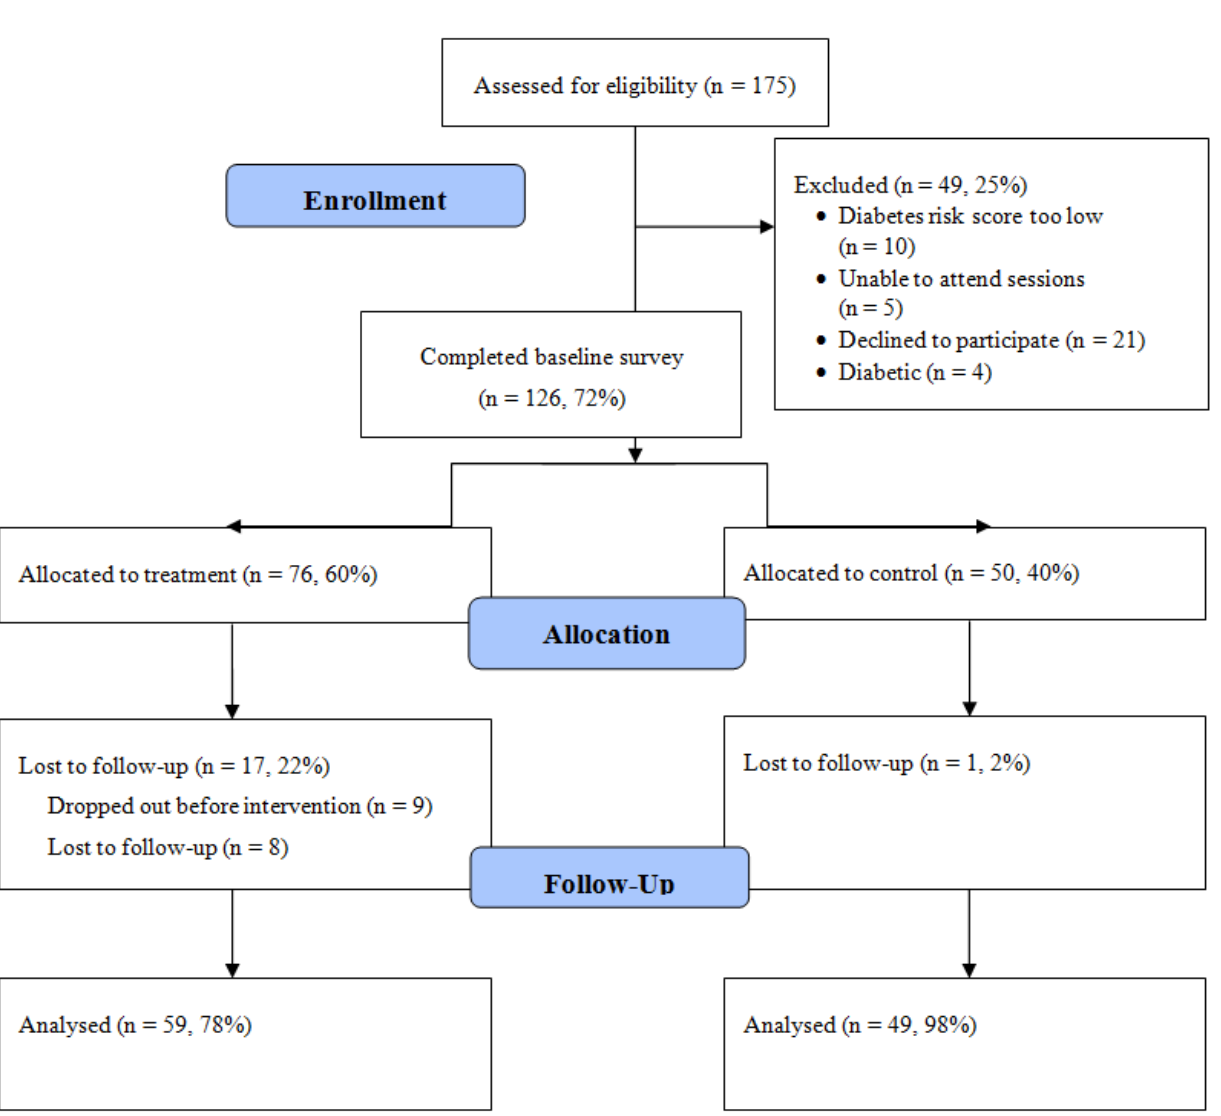
Figure 1. CONSORT Diagram of Study